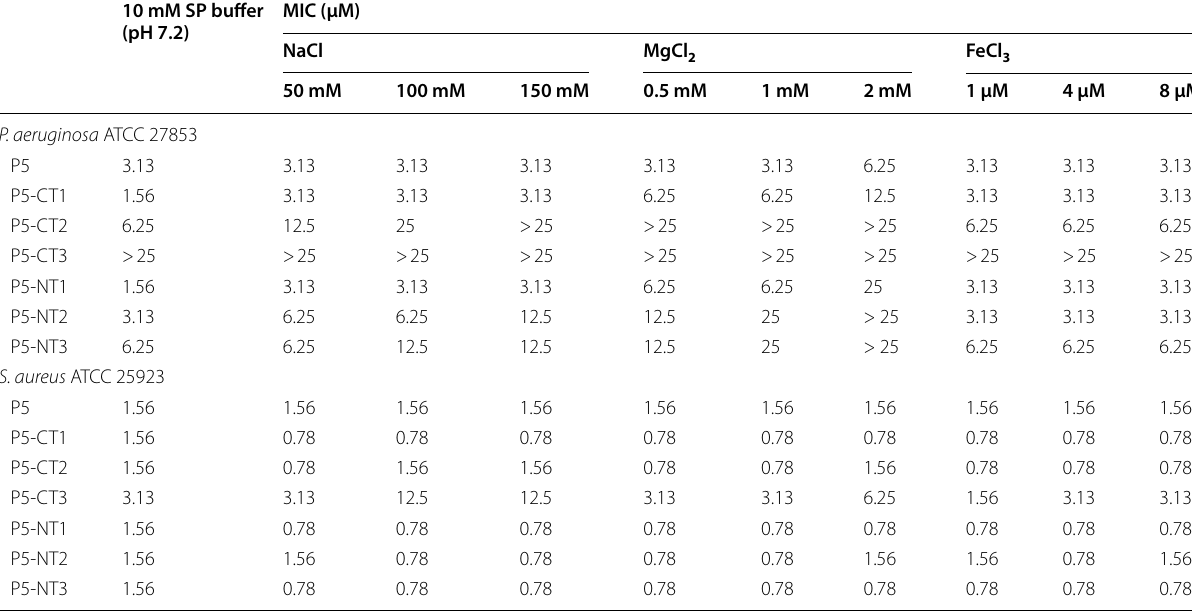
Table 3 Effect of various concentrations of salt on the antibacterial activity of peptides against P. aeruginosa ATCC 27853 and S. aureus ATCC